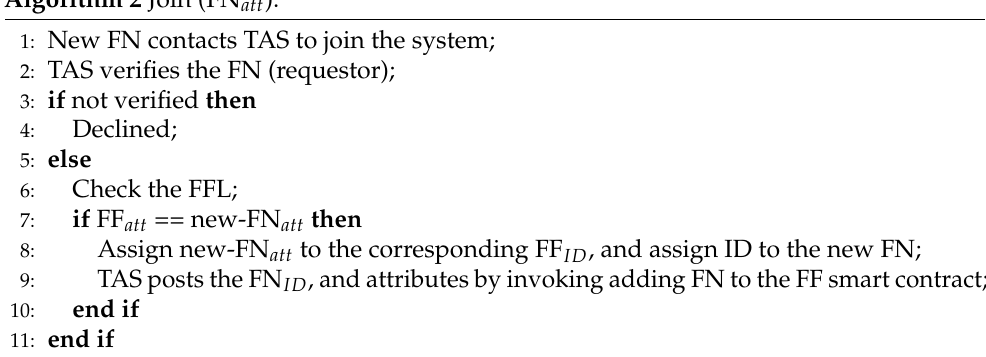
Algorithm 2 Join (FN att